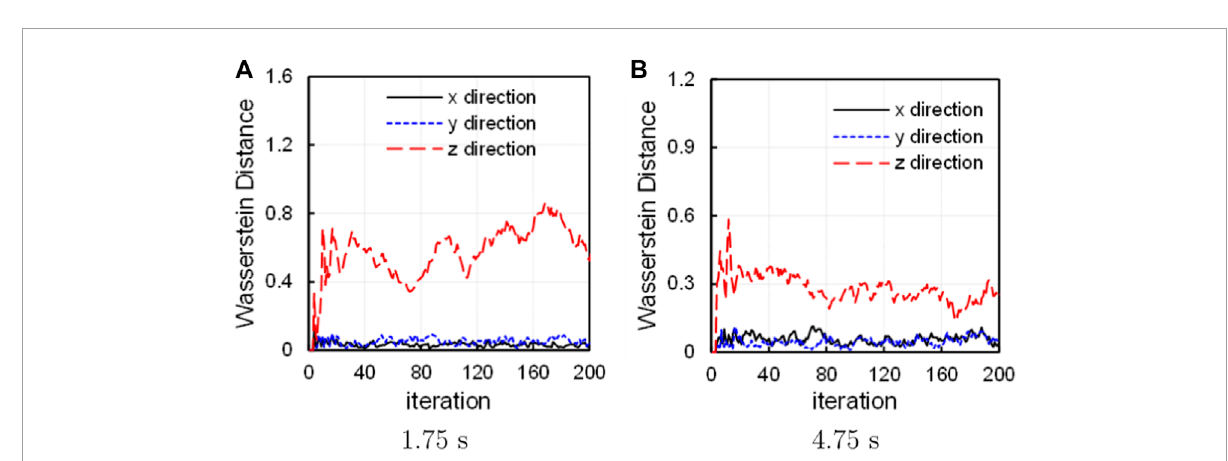
FIGURE 9 WD curves at (A) 1.75 s and (B) 4.75 s, with ASM.